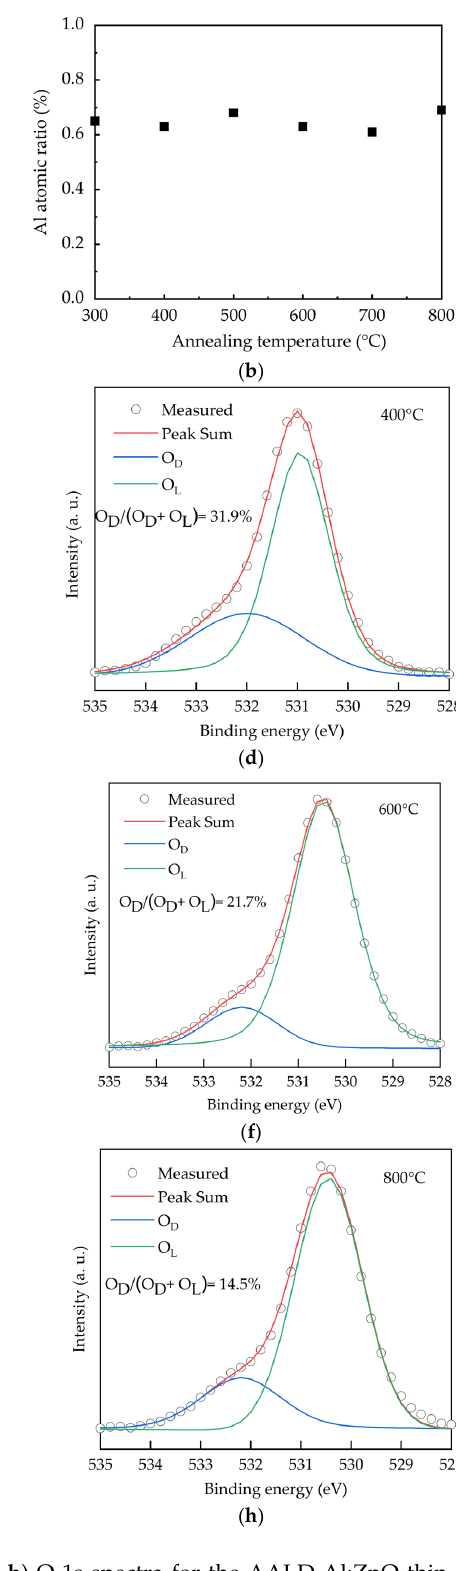
Figure 1. ( a ) XPS spectra, ( b ) Al content and ( c – h ) O 1s spectra for the AALD Al:ZnO thin films annealed at di ff erent